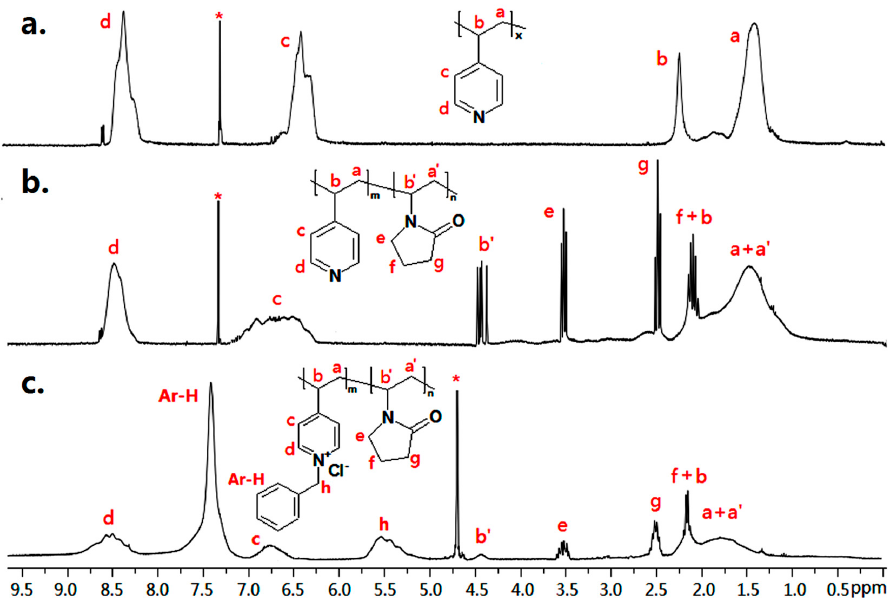
Figure 2. 1 H NMR spectra of ( a ) poly(4-vinyl pyridine) in CDCl 3 ; ( b ) poly(4VP- co -NVP) in CDCl 3 ; and ( c ) poly(BVPC- co -NVP) in D 2 O. The signals originating from solvents are marked with asterisks.